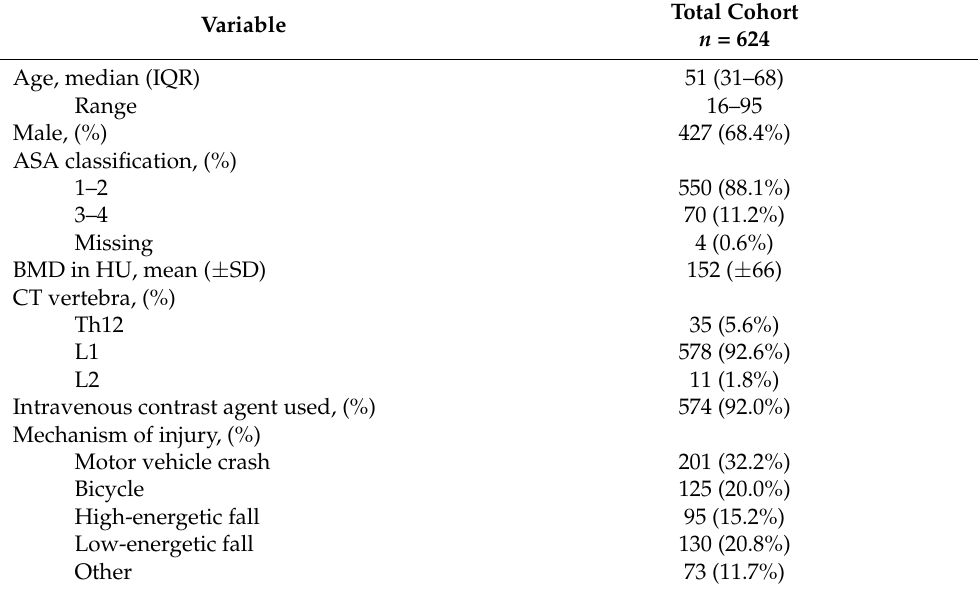
Table 1. Cohort characteristics.